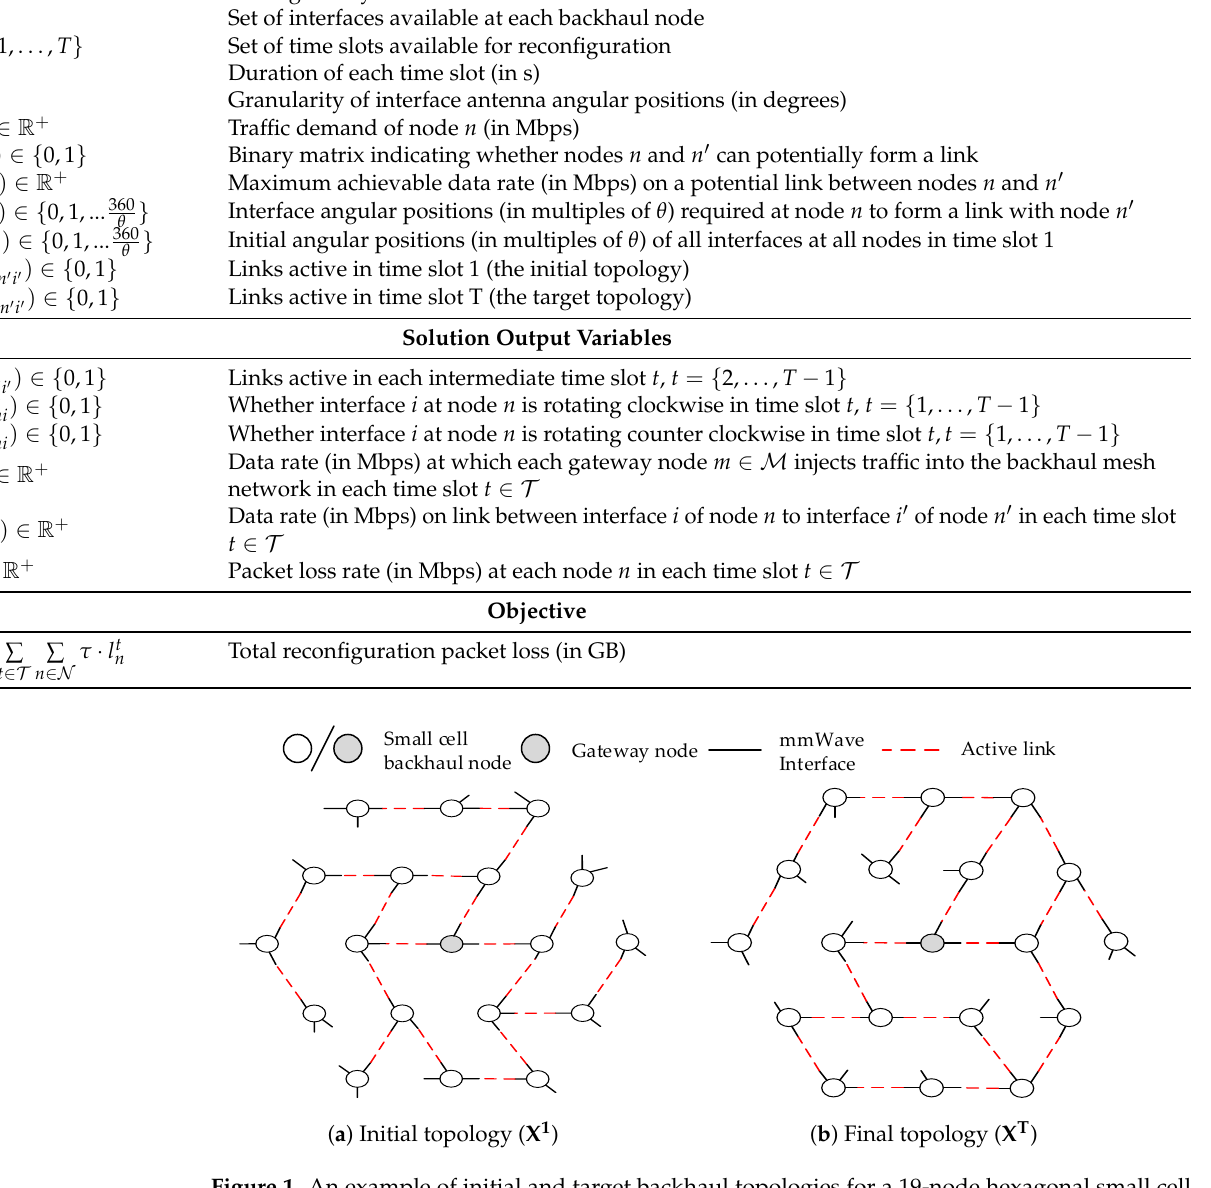
Figure 1. An example of initial and target backhaul topologies for a 19-node hexagonal small cell (SC) deployment with one